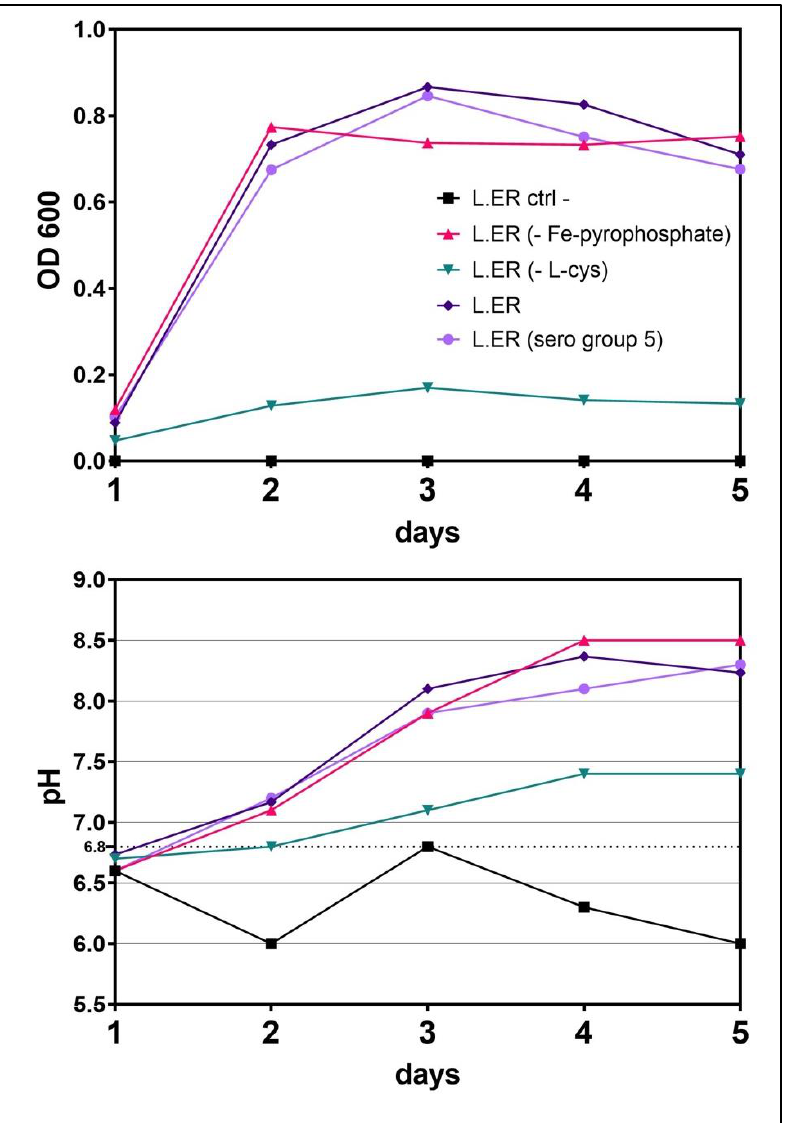
Figure A1. Optical density at 600 nm (OD 600) ( top ) and pH ( bottom ) of cultures of Legionella pneumophila ssp1 or L. pneumophila ssp5 grown in Legionella enrichment broth (L.ER) supplemented or not (indicated by minus-sign) with Fe-pyrophosphate or L-cysteine (L-cys).